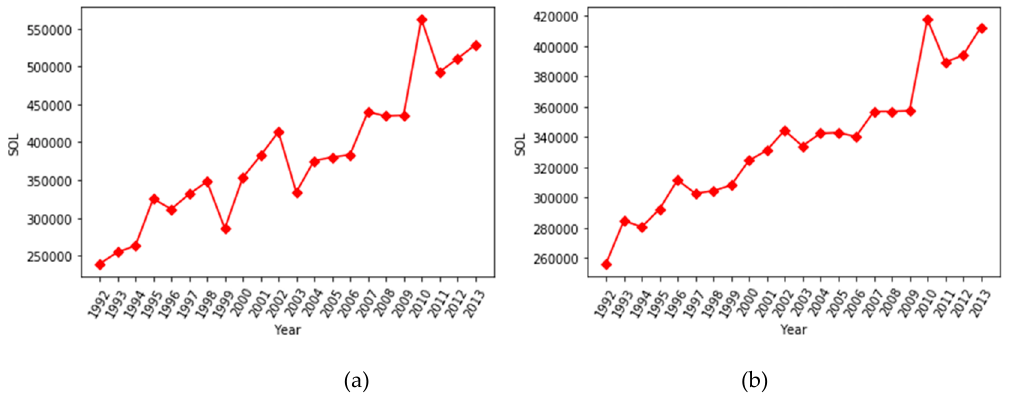
Figure 7. SOL of DMSP NTL in Beijing before ( a ) and after ( b ) calibration.